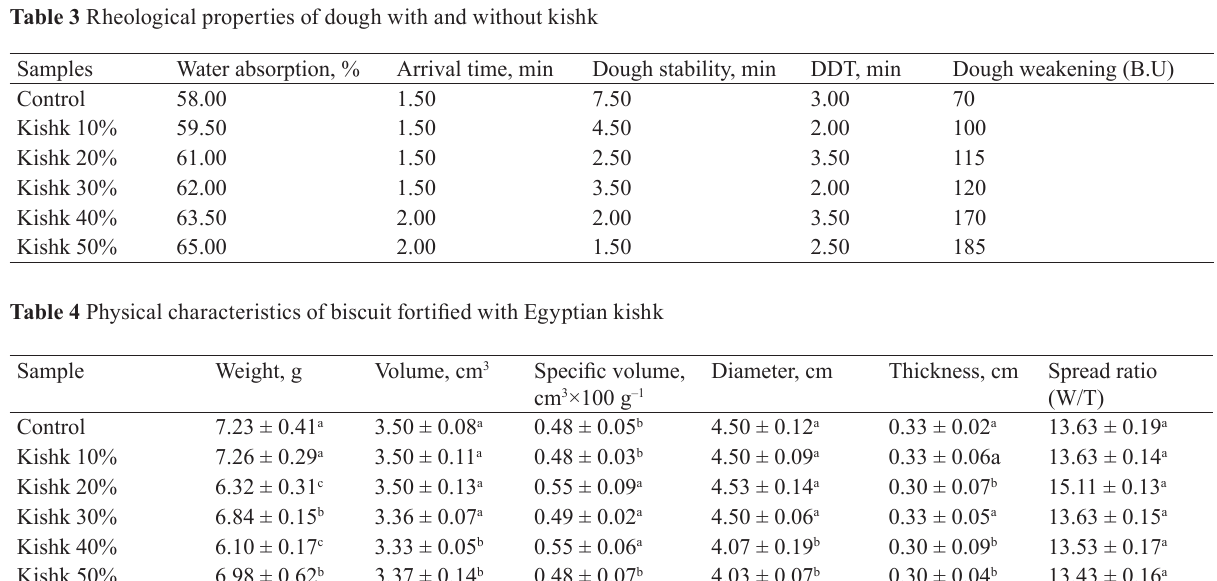
Values are the mean ± SD of three replicates. Mean followed by different letters in the same column differs significantly ( P ≤ 0.05) Table 5 Effect of Egyptian kishk on hardness and color determinants of biscuits Sample